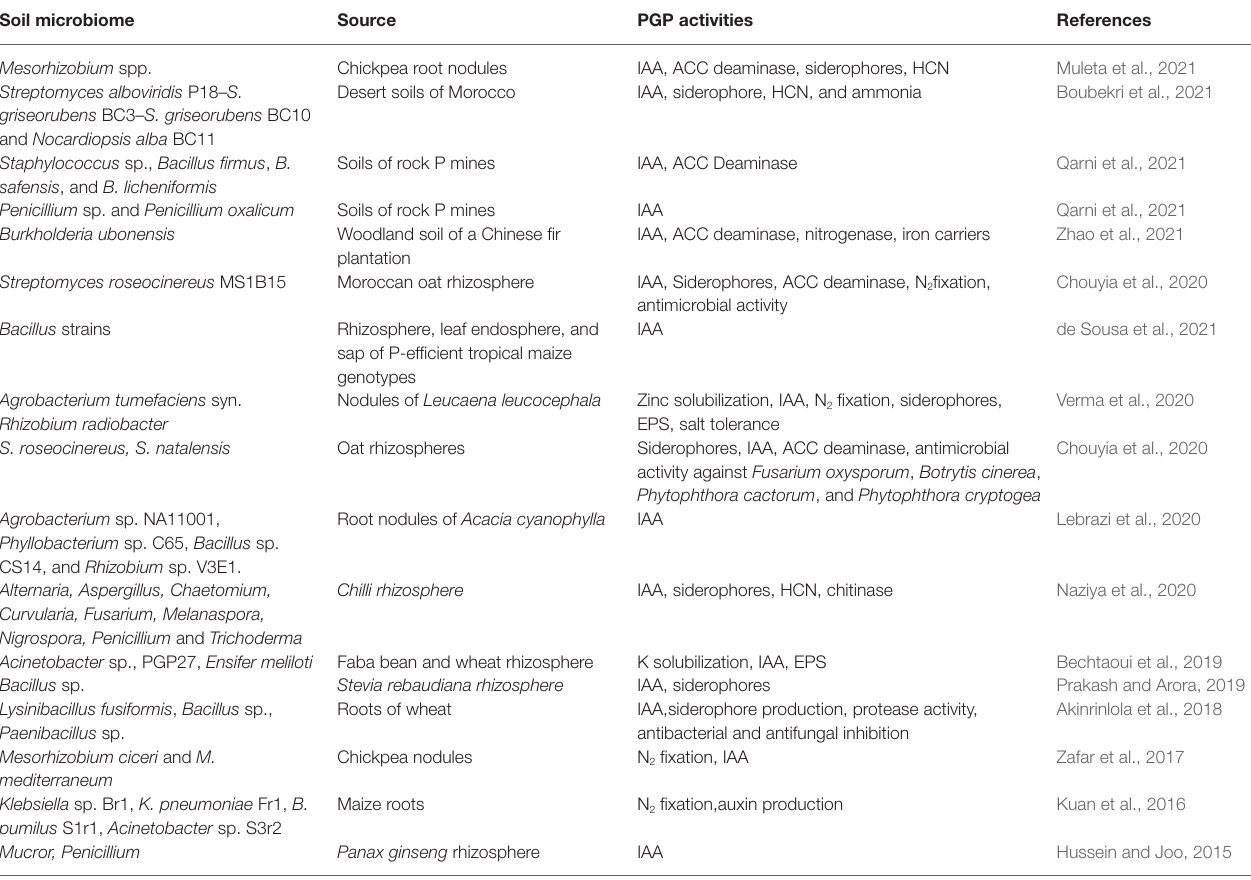
TABLE 3 | Plant-growth-promoting active biomolecules released by PSM. Soil